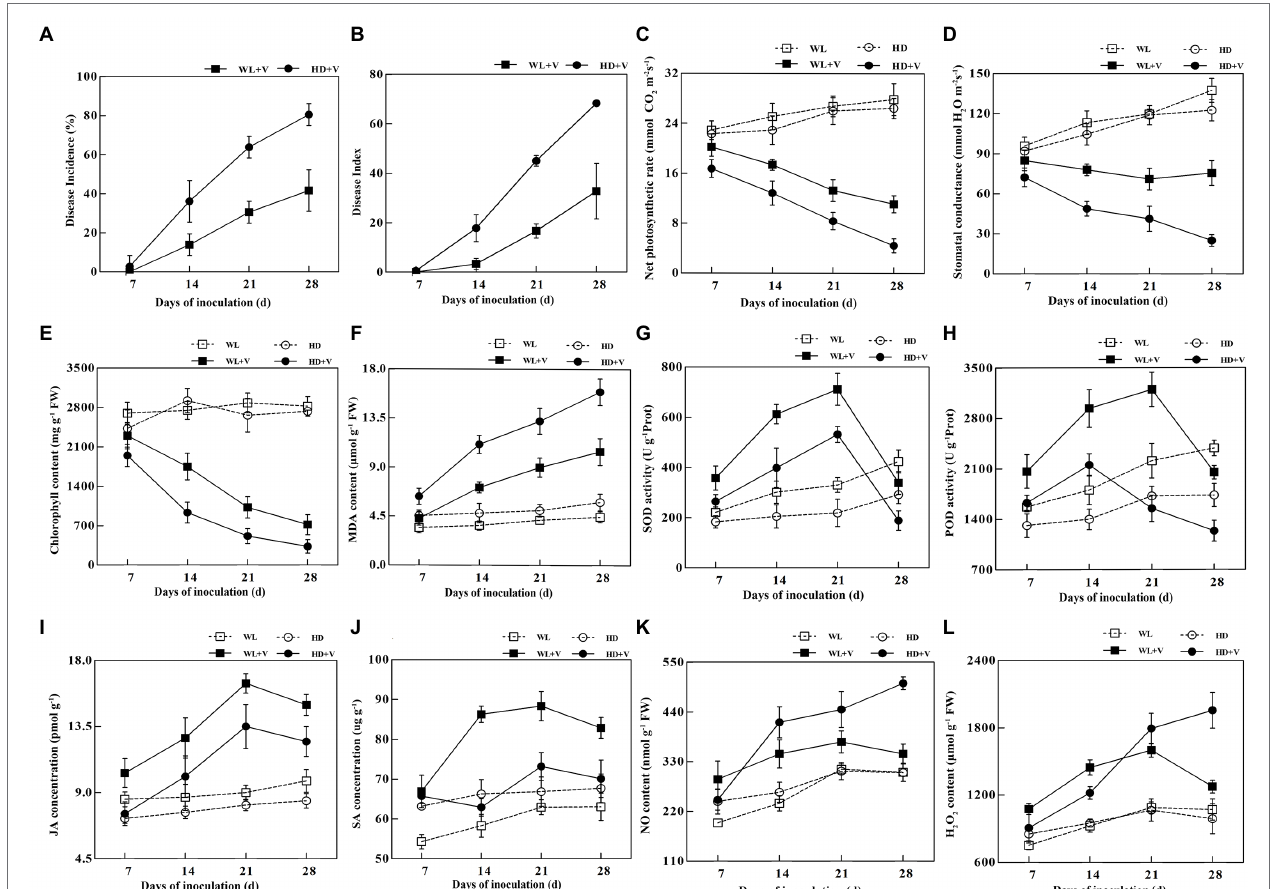
FIGURE 1 | Linear charts of physiological and biochemical indicators of WL343HQ inoculated with Verticillium alfalfae (WL + V), Dryland inoculated with V. alfalfae (HD + V), and control groups (WL and HD). (A) Disease incidence. (B) Disease index. (C) Net photosynthetic rate. (D) Stomatal conductance. (E) Chlorophyll content. (F) MDA content. (G) SOD activity. (H) POD activity. (I) JA concentration. (J) SA concentration. (K) NO content. (L) H 2 O 2 content. Data are presented as mean ± SD; n = 10 for each